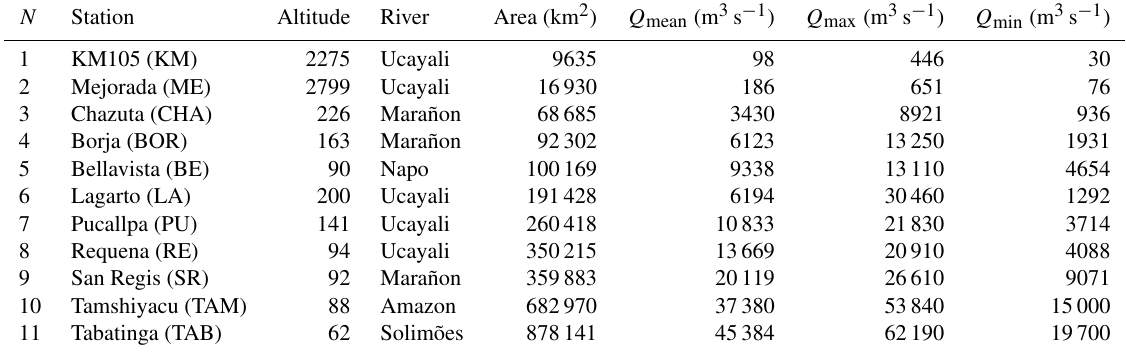
Table 1. Characteristics of streamflow gauging stations in the Amazon Basin of Peru and Ecuador: altitude, river, drainage area, annual mean streamflow ( Q mean ), maximum streamflow ( Q max ) and minimum streamflow ( Q min ) in cubic meters per second.